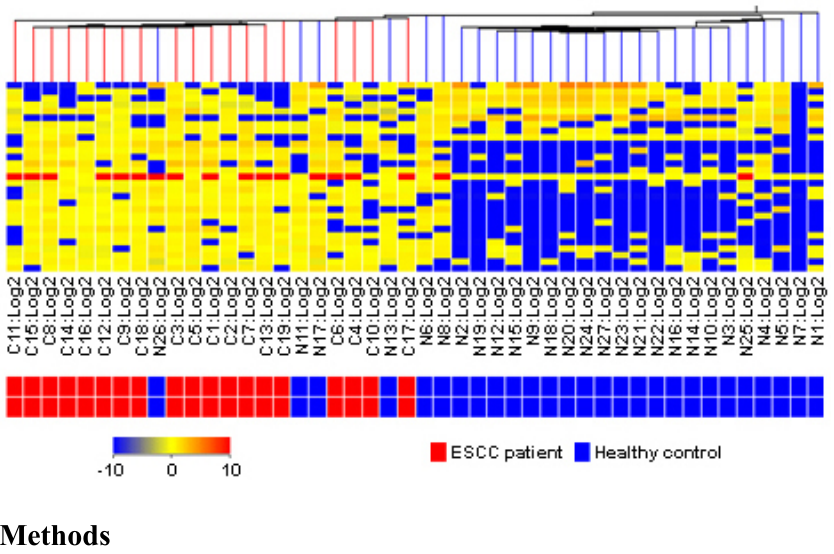
Figure 3. Hierarchical cluster analysis of plasma metabolic profile for distinguishing ESCC patients from healthy